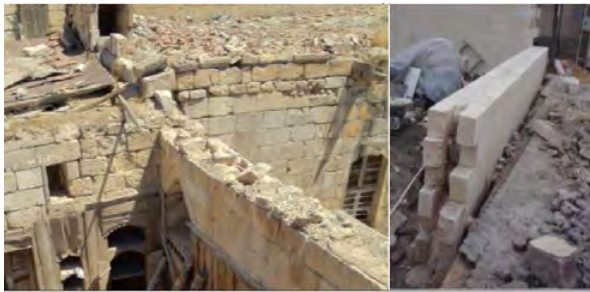
Figure 11. Use Of Natural Stone Material In WallConstruction (Tas¸tan, 2014)